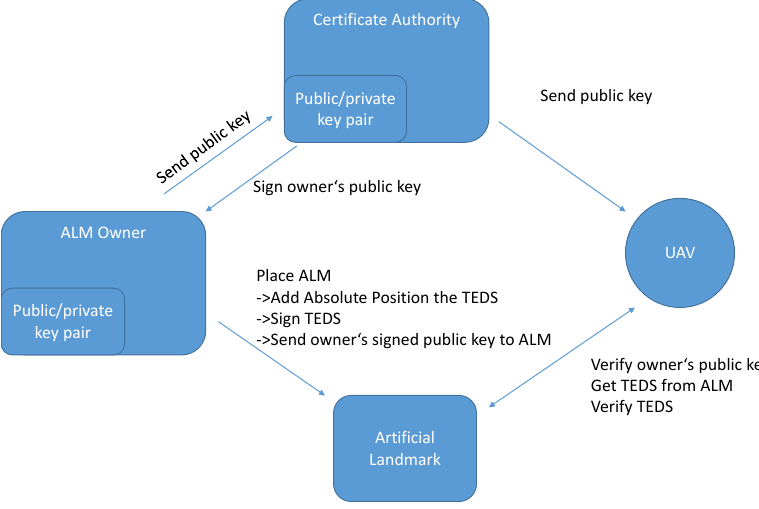
Figure 4. Flow graph of landmark deployment and security process.